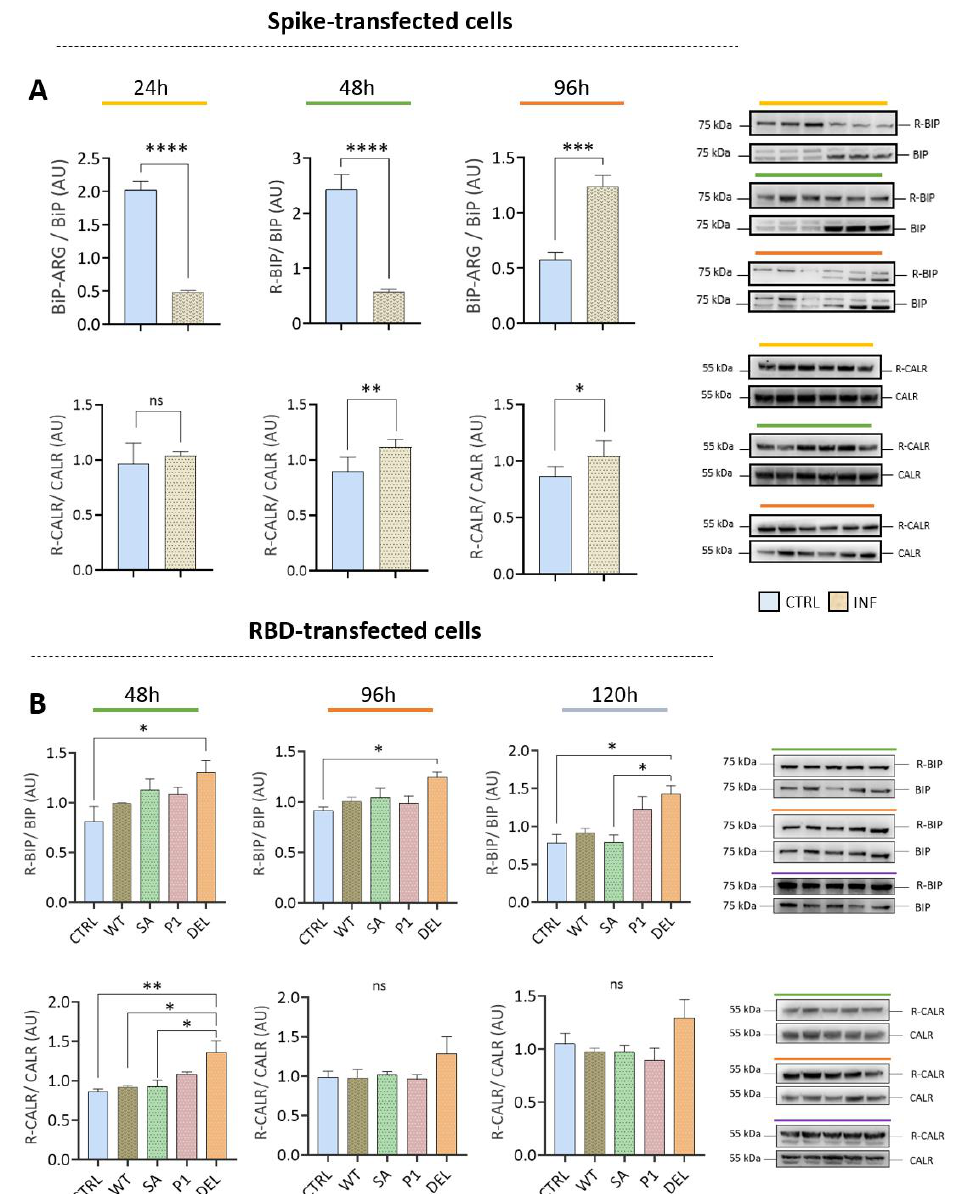
Figure 6. HEK 293T cells transfected with the SARS-CoV-2 (classical variant) spike protein and the receptor-binding domains (RBD). ( A ) Representative images of Western blot analysis of R-BiP/BiP and R-CALR/CALR proteins of cells transfected with the spike protein. ( B ) Representative images of Western blot analysis of R-BiP/BiP and R-CALR/CALR proteins of cells transfected with the RBD region of the wild-type (classic), Beta (South Africa), P1 (Brazil), and Delta (India) variants. Each point represents an independent experiment ( n = 3). The level of significance indicates: **** p < 0.0001; *** p < 0.001; ** p < 0.005; * p < 0.05 in relation to the control group (CTRL). Each point represents an independent experiment ( n = 3). ns indicates no